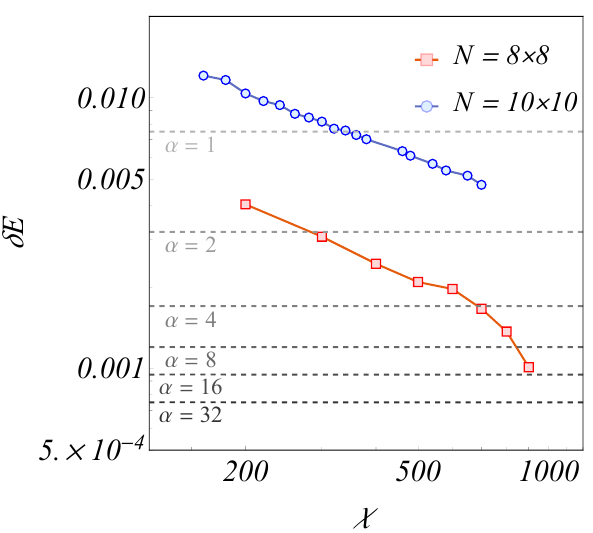
Figure 6: Relative error of the 2D Heisenberg ground-state energy compared with the best available estimates obtained by the finite-size Quantum Monte Carlo analysis in Ref. [ 53 ] . Symbols are TTN results for two different system sizes as function of the maximum bond dimension. Dashed lines represent RBM accuracy from Ref. [ 13 ] for the 10 × 10 system and different hidden variable densities α ∈ [ 1,32 ]